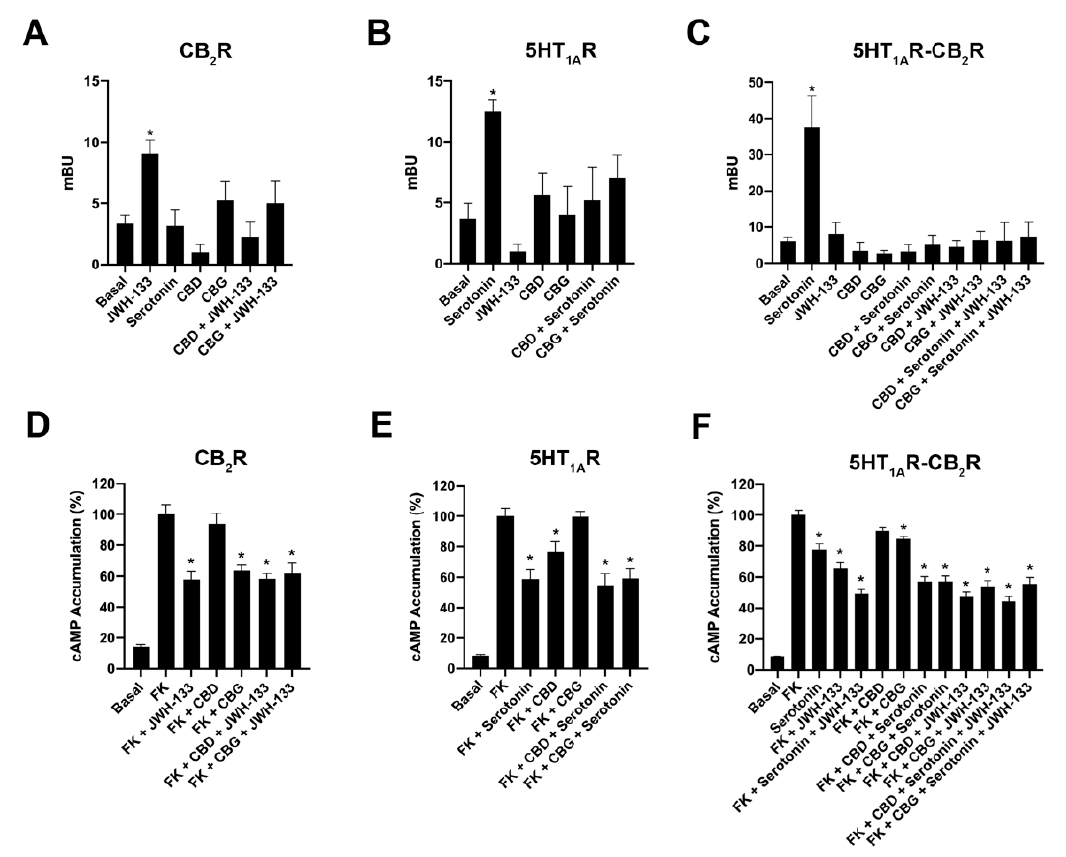
Figure 2. Effect CBD or CBG on the functionality of receptors expressed in HEK-293T cells. ( A – C ) β -Arrestin 2 recruitment assays were performed in HEK-293T transfected with cDNAs encoding for either CB 2 R-YFP (1.5 μ g) ( A ), 5HT 1A R-YFP (1.5 μ g) ( B ), or CB 2 R (1.5 μ g) and 5HT 1A R-YFP ( C ). In all